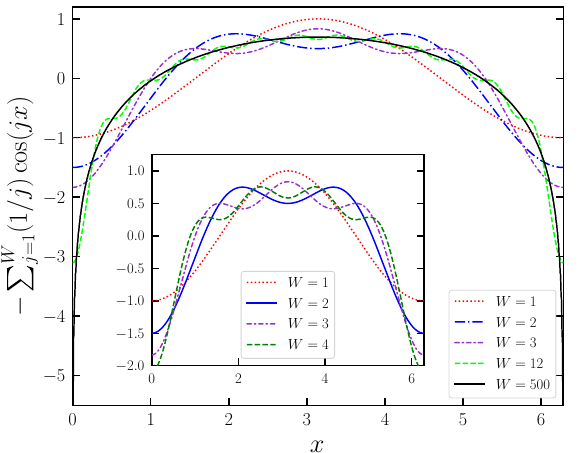
Figure 1. The behavior of the new potential of the generalized standard map discussed here for several representative values of W . The inset of the graph presents the conversion of minima and maxima with increasing W . In each increment step, newly arisen maxima can be clearly